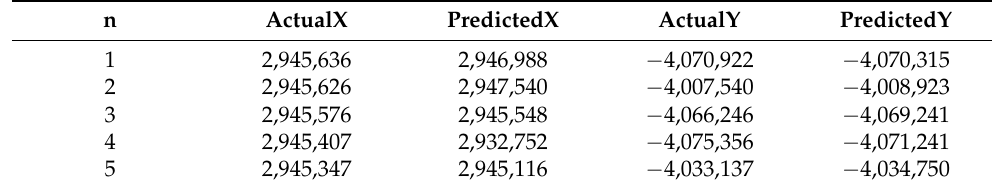
Table 3. Examples of transformed values of actualX, predictedX, actualY, and predictedY.